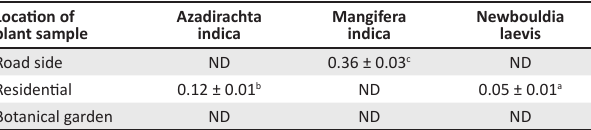
TABLE 3: Cadmium concentration (ppm) in selected medicinal plants across locations within the University of Ibadan. Location of plant sample